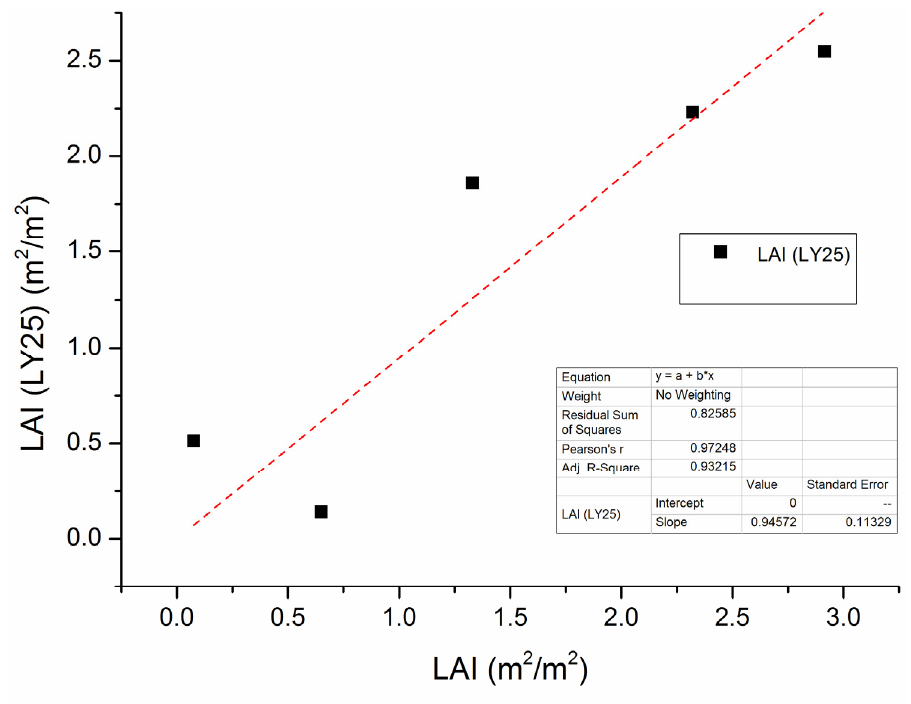
Figure 9. Measured (x-axis) vs. modeled (y-axis) LAI using the LY25 model